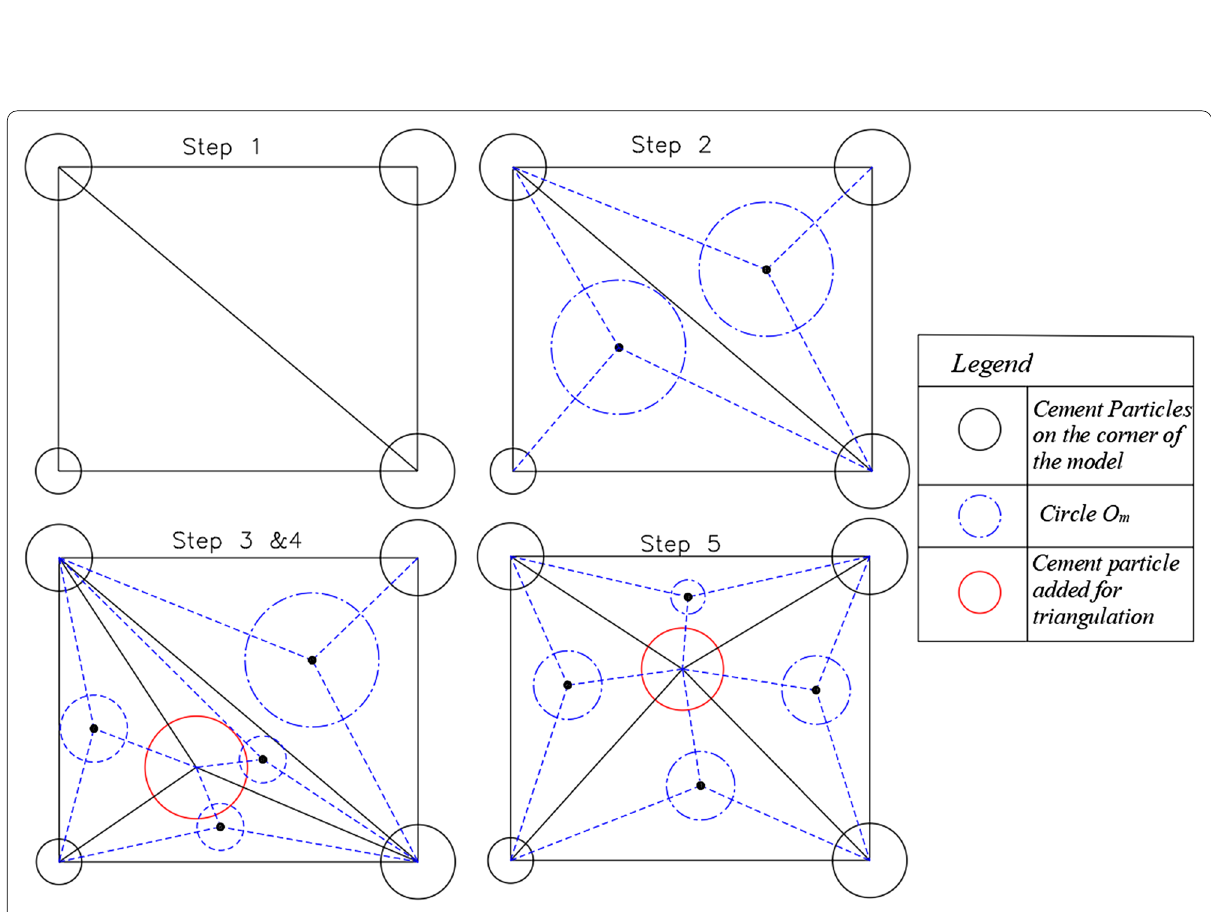
Fig. 6 Steps for generalized Delaunay